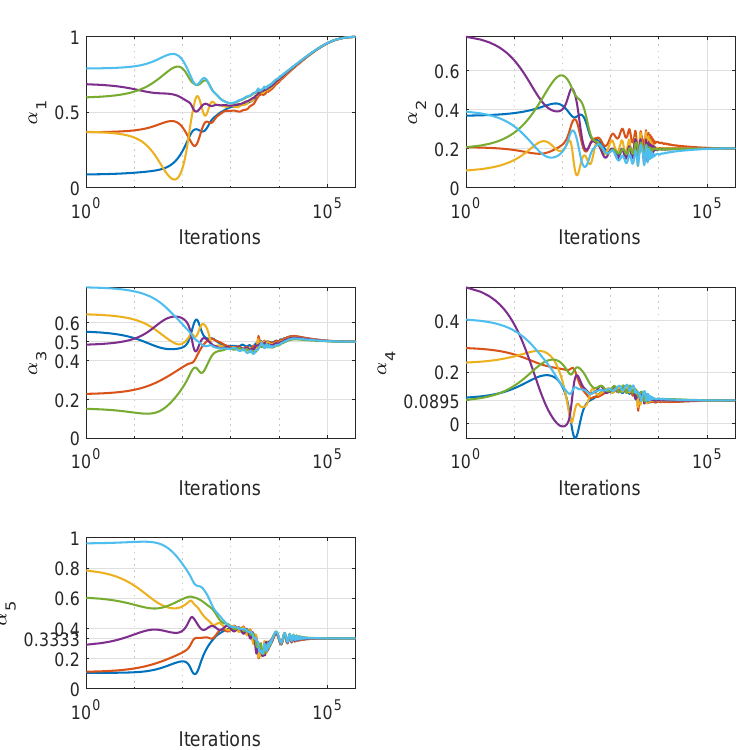
Figure 7. ααα t convergence trajectories implemented by Lagrange-based method.